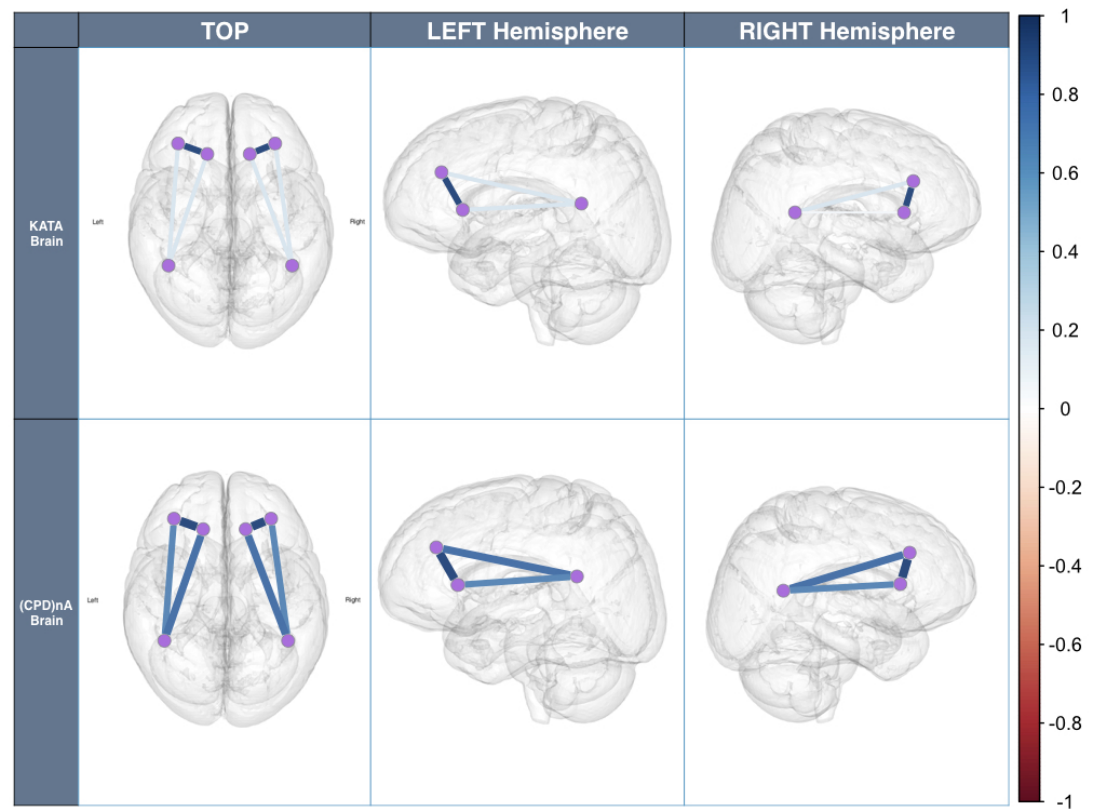
Figure 9. Brain Overlay of cross-correlation among sensors F7, F3 and P7 , as well as F4, F8 and P8 of Subject